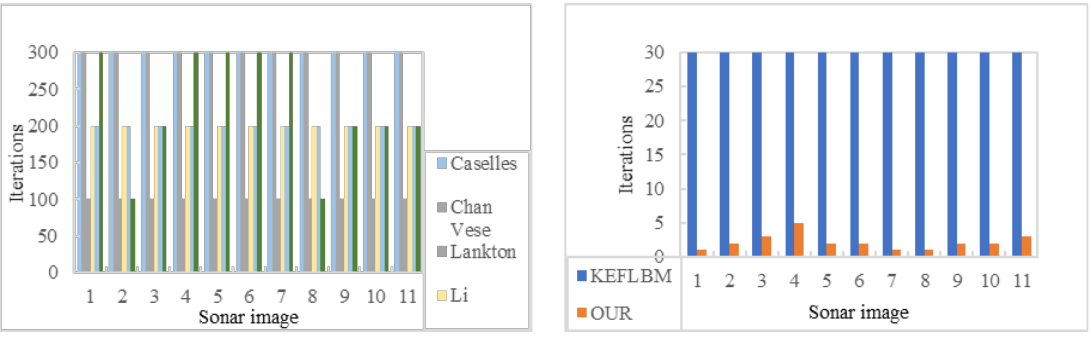
Figure 10. Comparison of number of iterations for the level set equation (LSE) and LBM. Data set is the same as the eleven sonar images listed in Figure 7.